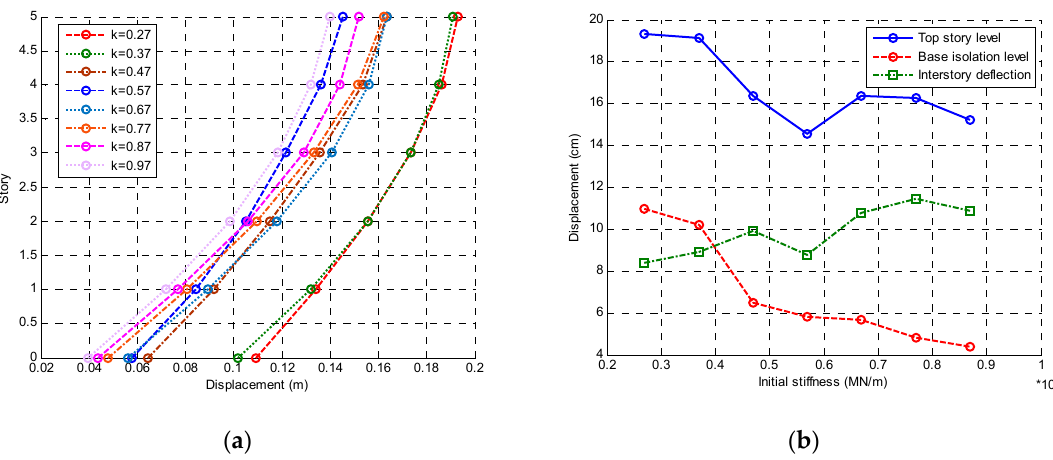
Figure 12. The results of ( a ) peak displacement for different initial stiffness of isolated support ( b ) peak displacement at the base isolation level and top story level for different initial stiffness of isolated support under the El Centro earthquake.